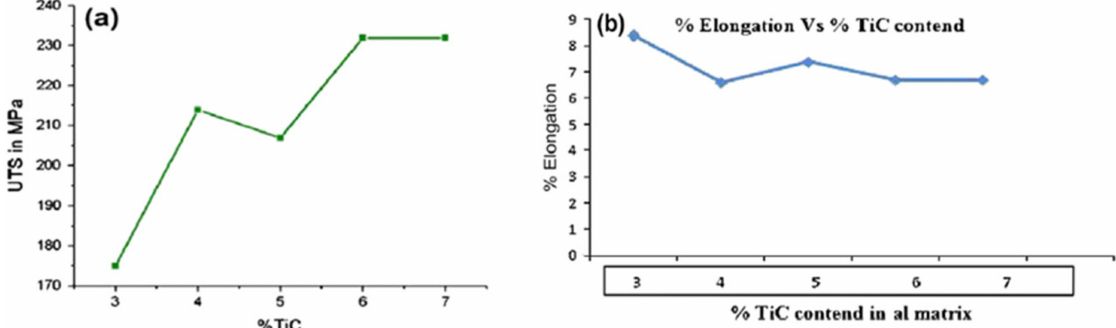
Figure 15. Effects of TiC reinforcement on the mechanical properties of AMMCs: ( a ) tensile strength; ( b ) ductility